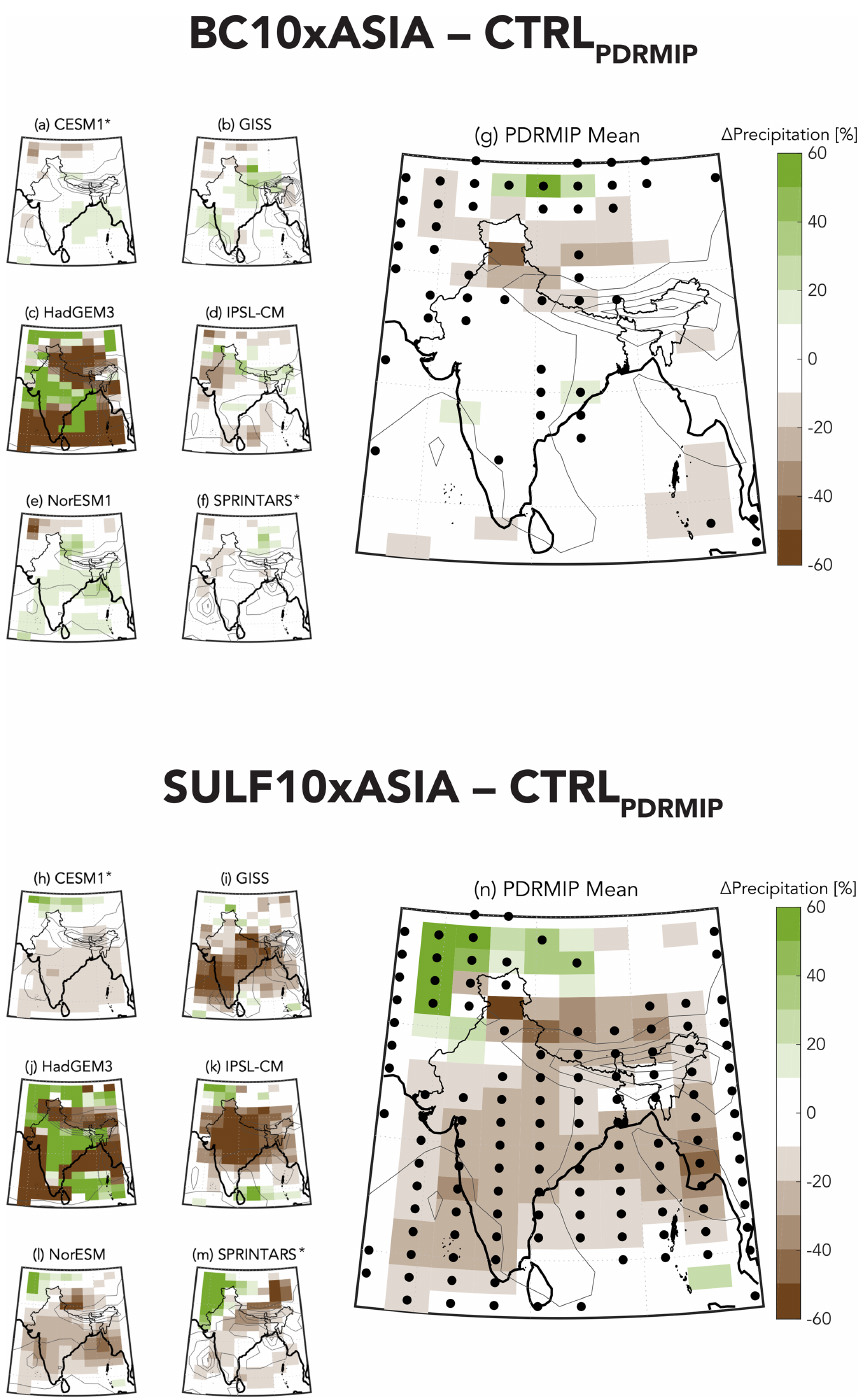
Figure 2. Percent change in summertime (JJAS) precipitation between (a–f) the BC10xASIA and the CTRL PDRMIP runs; (g) the multimodel mean of the change. Similarly, panels (h–m) represent the precipitation change in JJAS precipitation between the SULF10xASIA scenarios and the CTRL PDRMIP runs, and panel (n) represents the multimodel mean of the change. Stippled grid cells in panels (g) and (n) denote regions where at least five of the six models agree on the sign of the change. Grey contours indicate mean JJAS precipitation from the control experiment for each model at 5mmd − 1